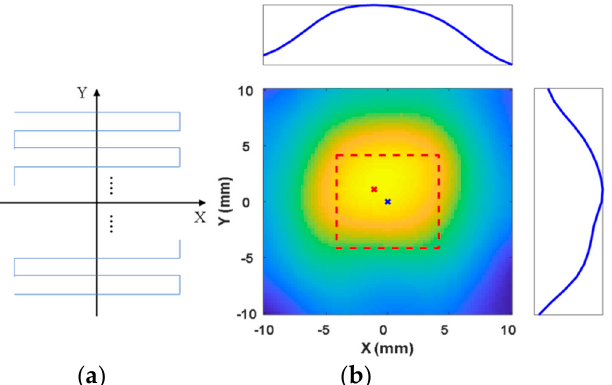
Figure 7. Comparison of locations of the highest intensity points of the particles and area. ( a ) The sequence of 2D scanning. ( b ) The reconstructed image based on the reflected signals.